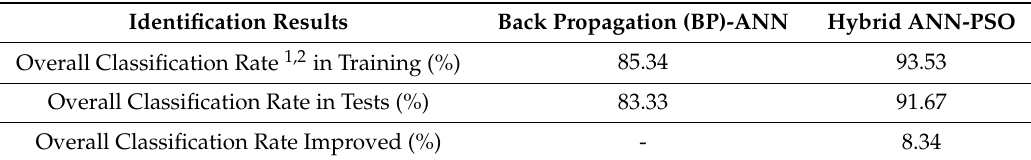
Figure 9. PSO trajectory obtained in this experiment. The elapsed time is ~1289.30 s. Table 3. Load identification results obtained by different ANN approaches used in this experiment.